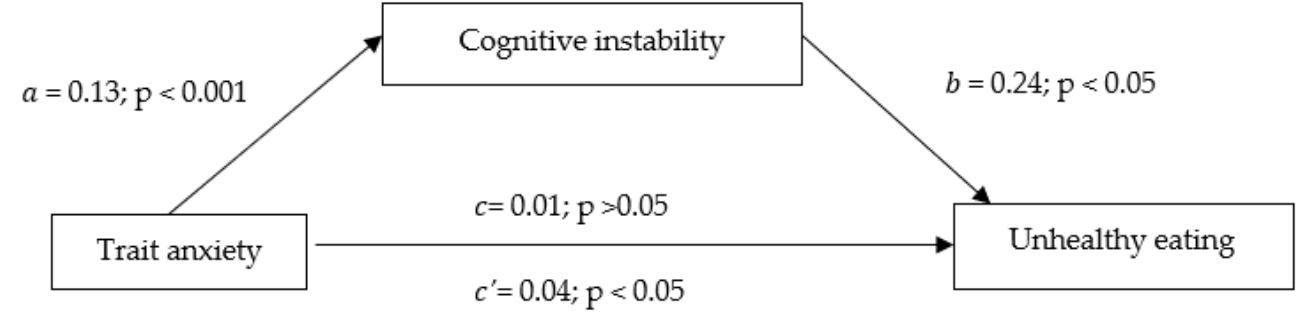
Figure 1. Mediation model for the effect of cognitive instability in the relationship between trait anxiety and unhealthy eating in adult women. Table 7. Mediation analysis: the effect of cognitive instability in the relationship between trait anxiety and unhealthy eating in adult women.